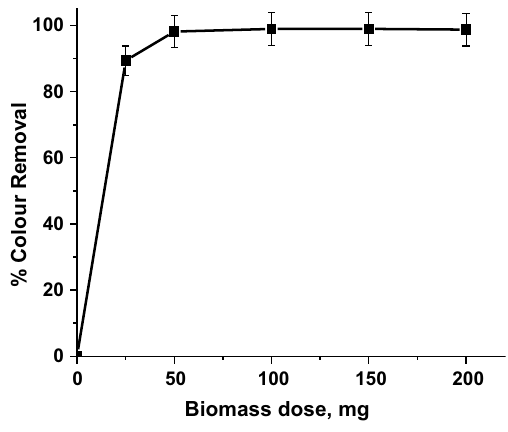
Fig. 2 Effect of biomass dose on removal of EB (dye concentration: 100 mg/L, 4 h)